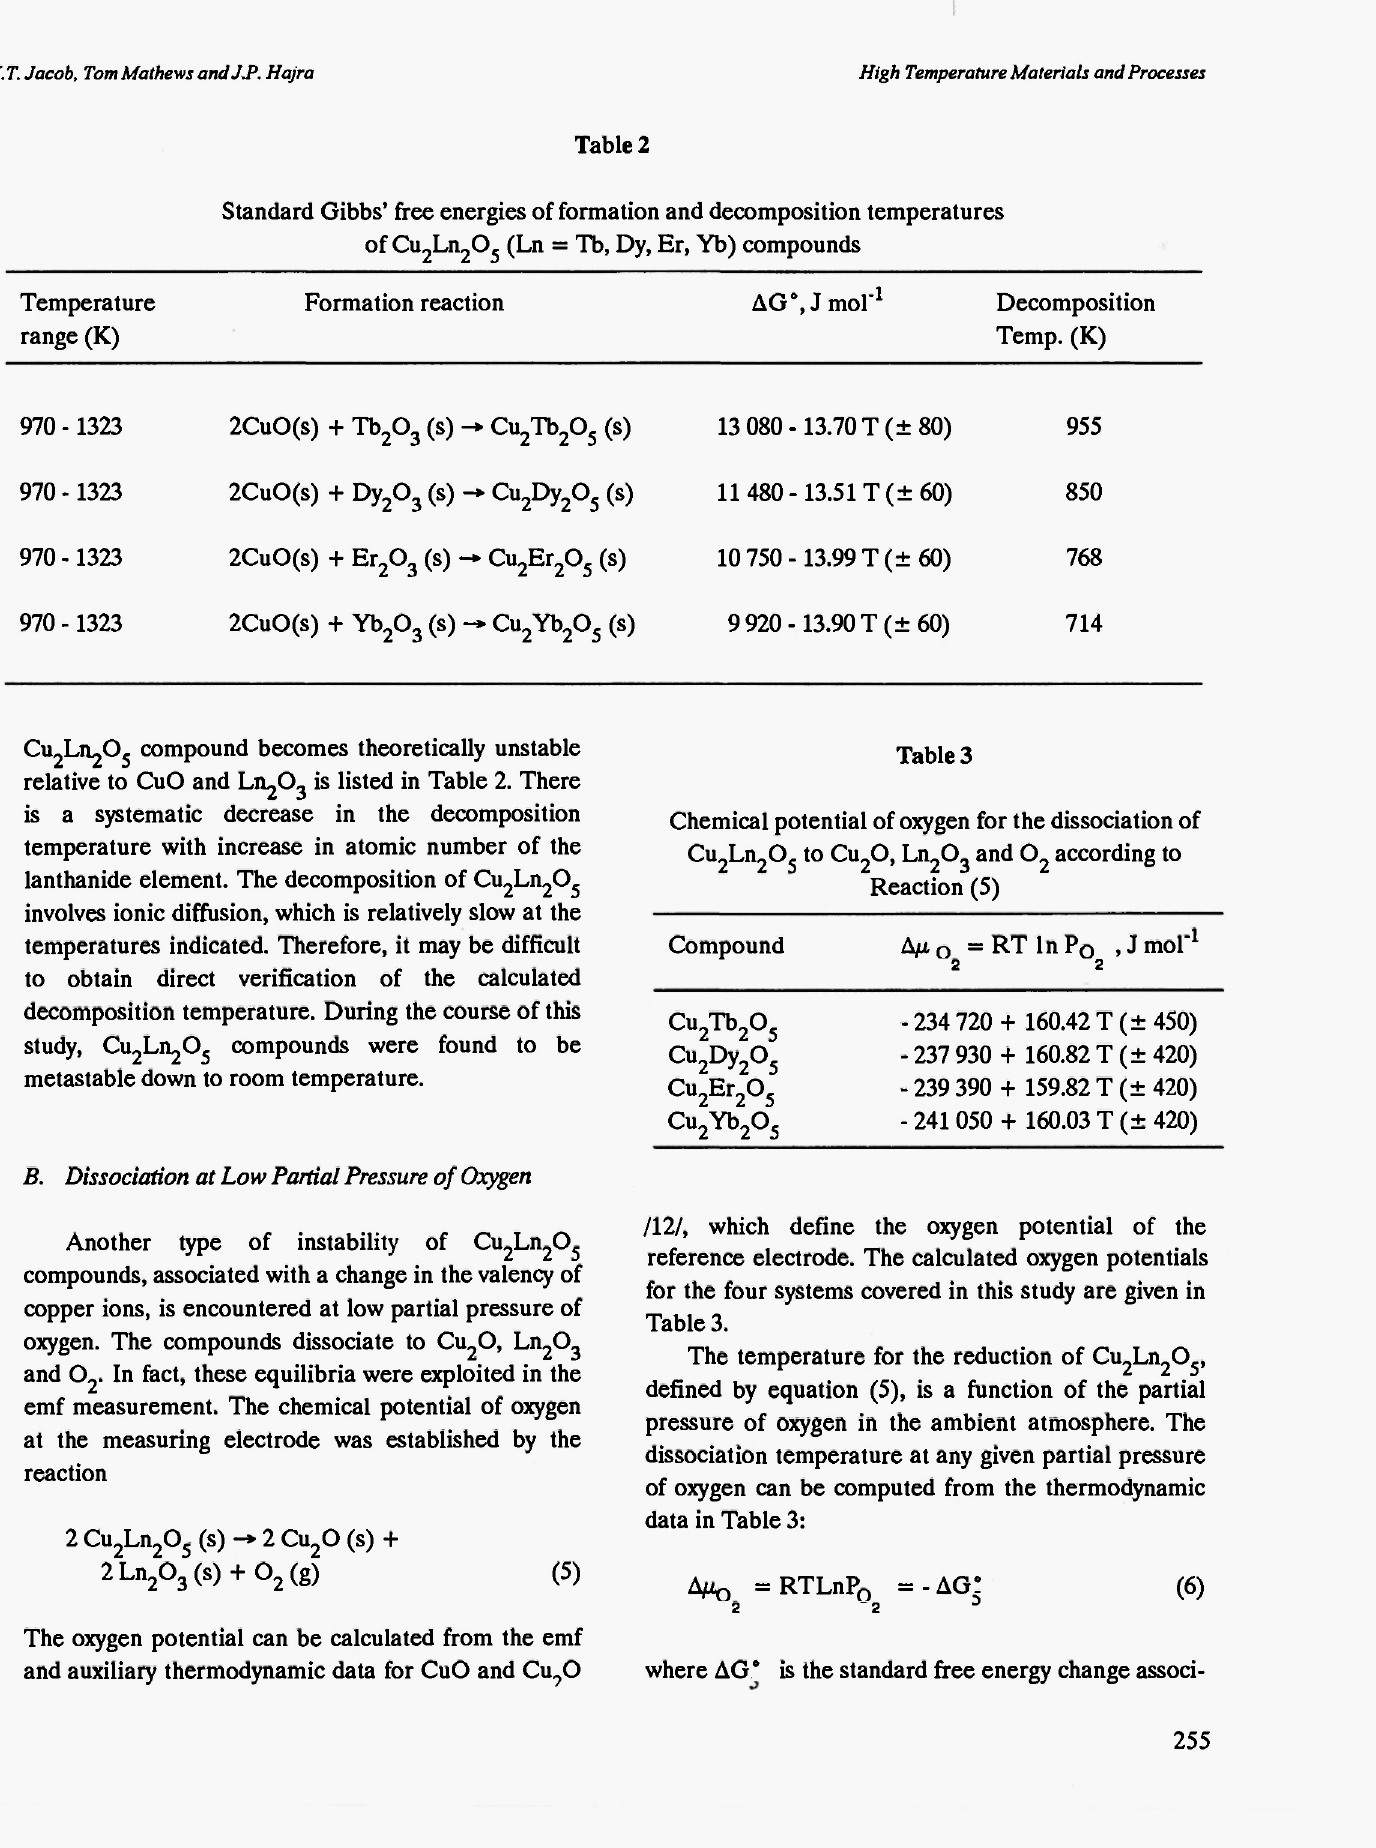
The temperature for the reduction of Cu 2 Ln 2 O s